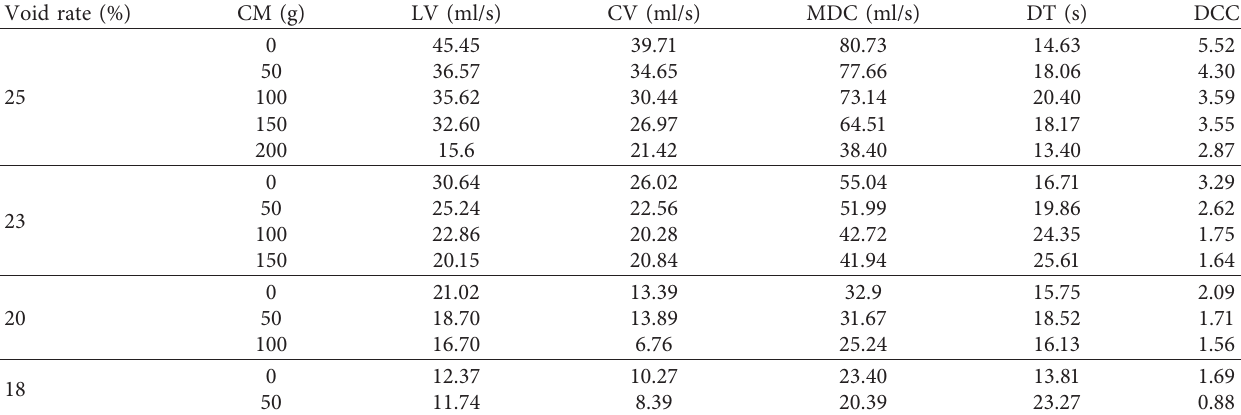
Table 5: Drainage decline of various void rates.